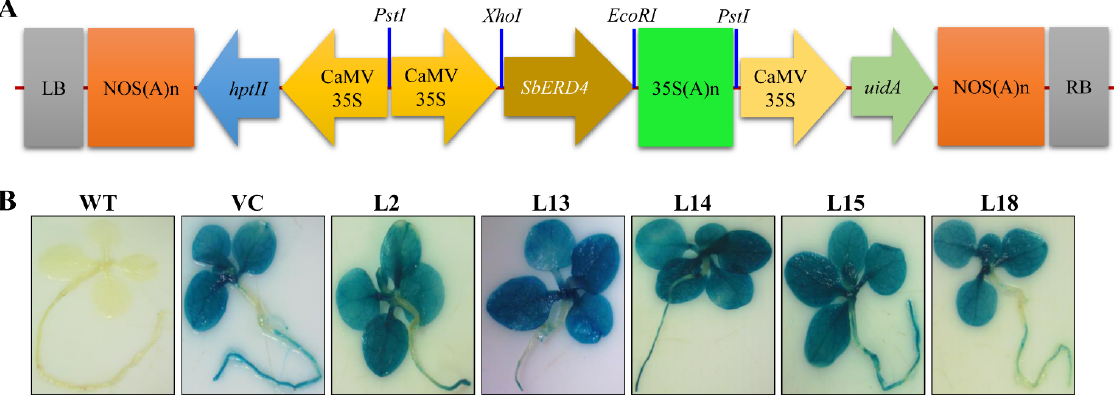
Figure 2. Gene construct and histochemical GUS assay. ( A ) Schematic representation of pCAM-